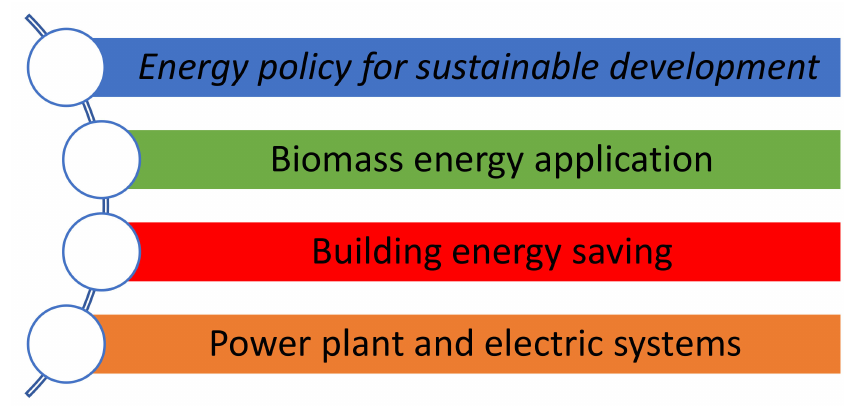
Figure 1. Main research